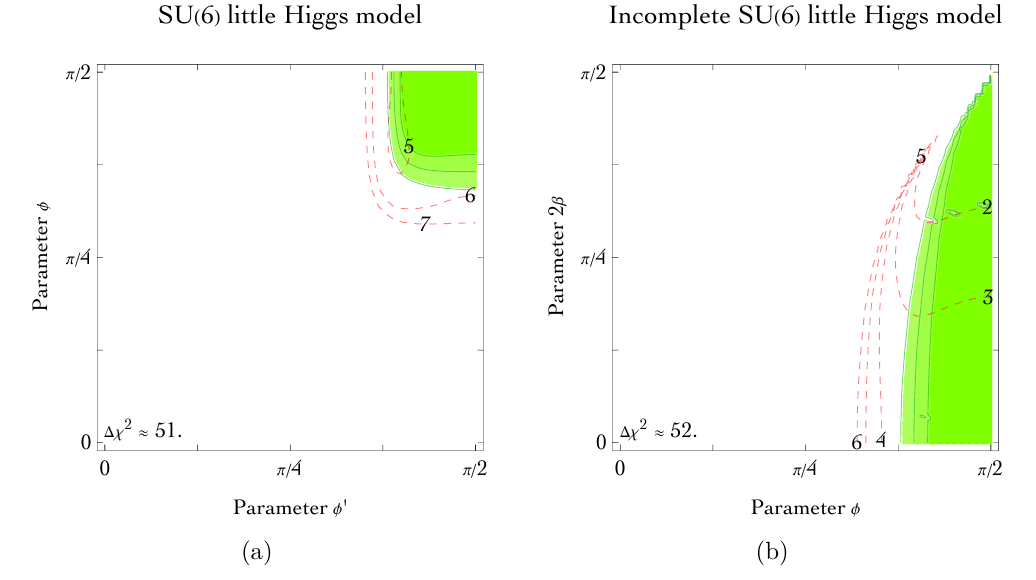
Figure 7. As in figure 6, for SU(6) little-Higgs